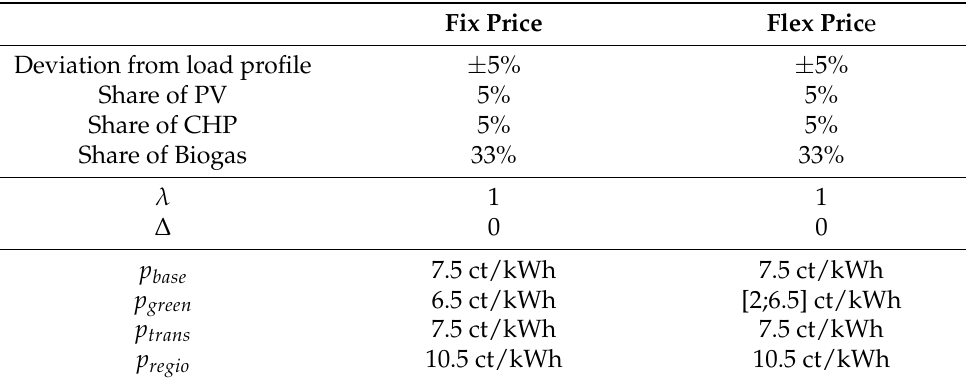
Table 6. Initial values and parameters.